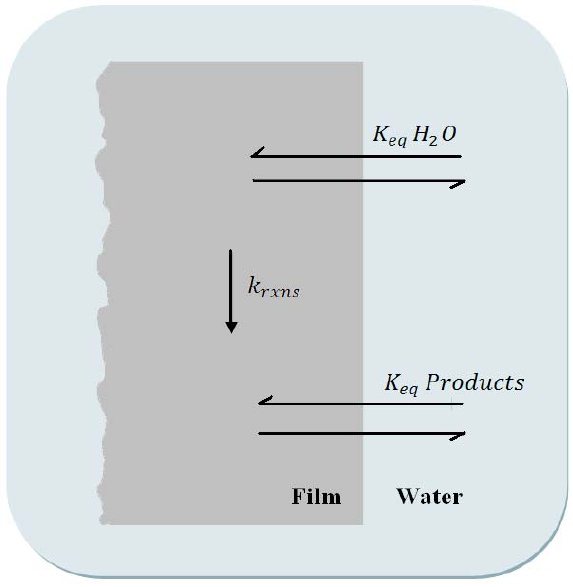
Figure 3. Generic description of the hydrolytic process in